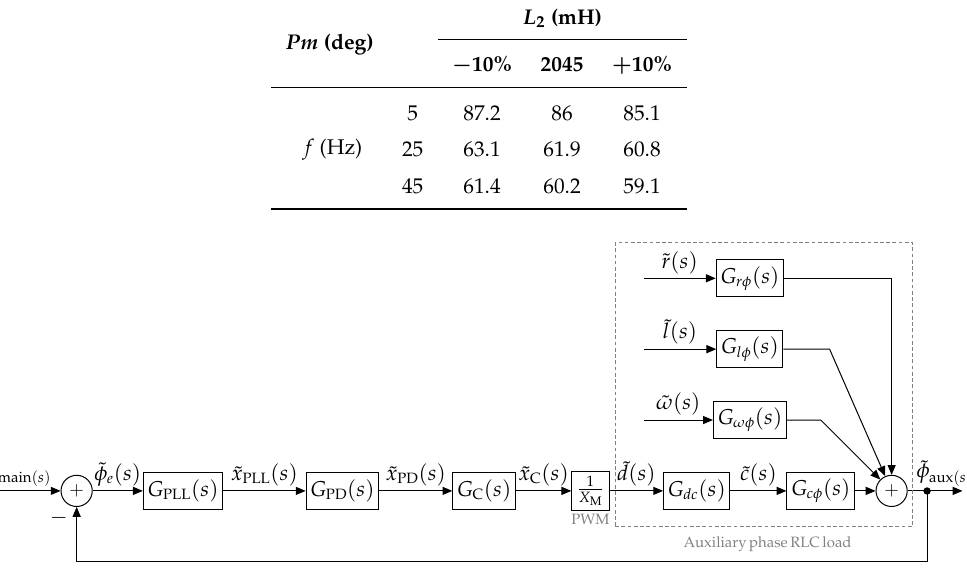
Figure 18. A linearized block diagram of the closed-loop (feedback) control of current phase advancing.